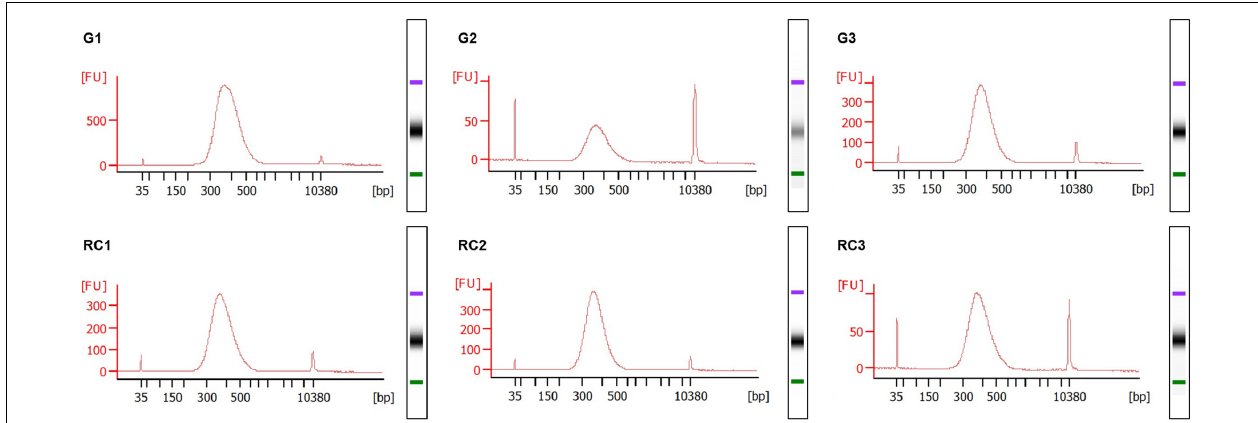
FIGURE 6 | Electropherograms of Whole Genome Bisulfite Sequencing (WGBS) libraries. NEXTflex R (cid:13) Bisulfite-Seq Library Prep Kit (Bioo Scientific) was used to prepare the libraries of the 3 days post infection (dpi) samples, strictly following the manufacturer’s instructions. The fragment size distribution of the libraries was checked in the Agilent R (cid:13) 2100 Bioanalyzer using the Agilent R (cid:13) High Sensitivity DNA Kit (Agilent Technologies, Inc., Santa Clara, CA, United States). Gall samples: G1 to G3; Control roots samples: RC1 to RC3. Standard size ladder in nucleotides (bp) is shown at the X -axis at the bottom of each graph. FU, fluorescent units at the Y -axis. A clear abundant major peak of around 360 bp size fragments is observed. The libraries and electropherograms were performed by an external sequencing company (AllGenetics & Biology SL, A Coruña, Spain).